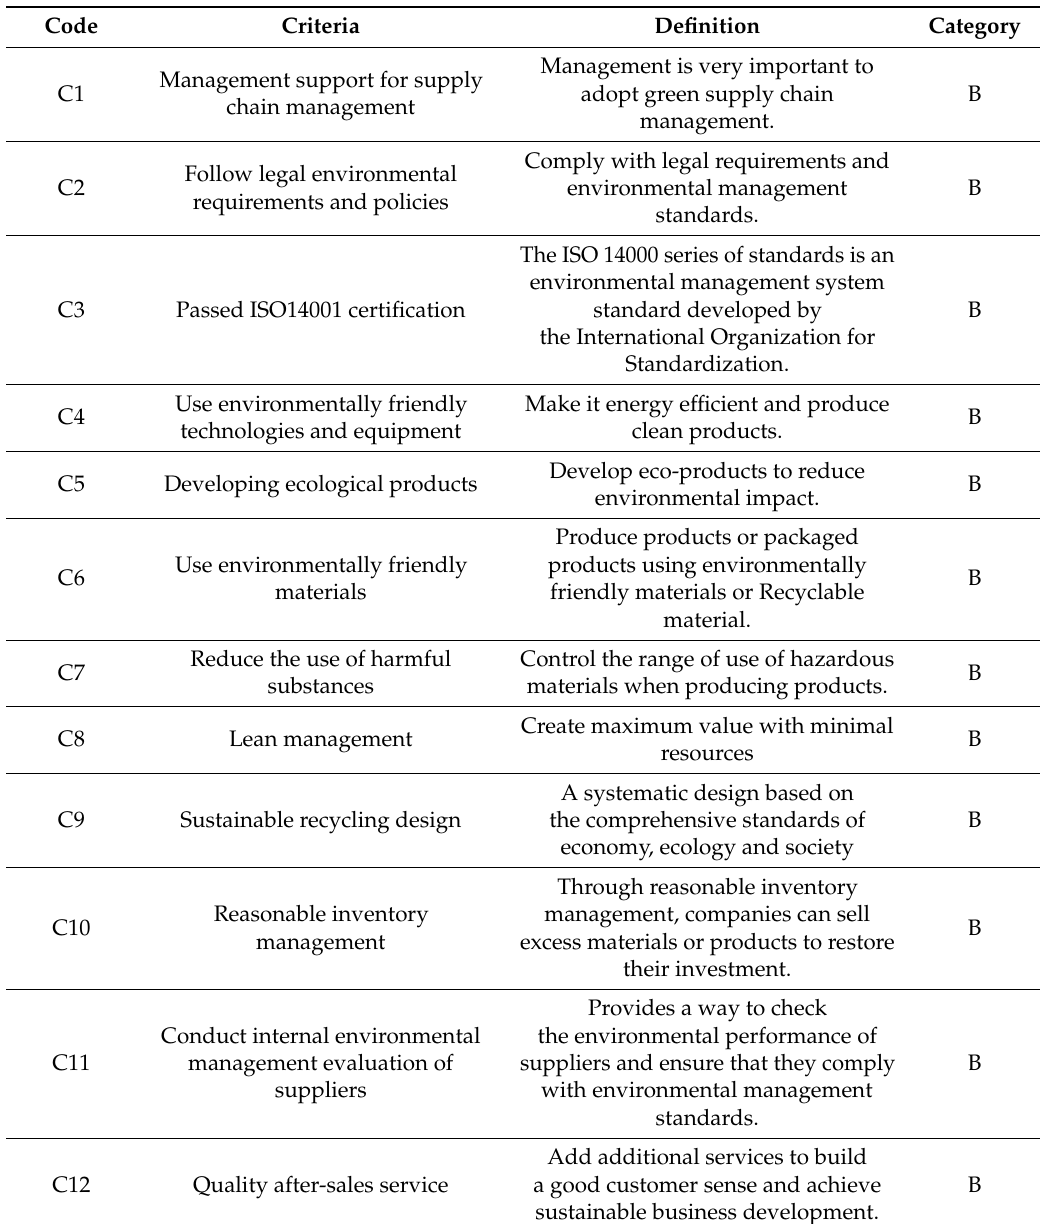
Table 2. Selected criteria in this